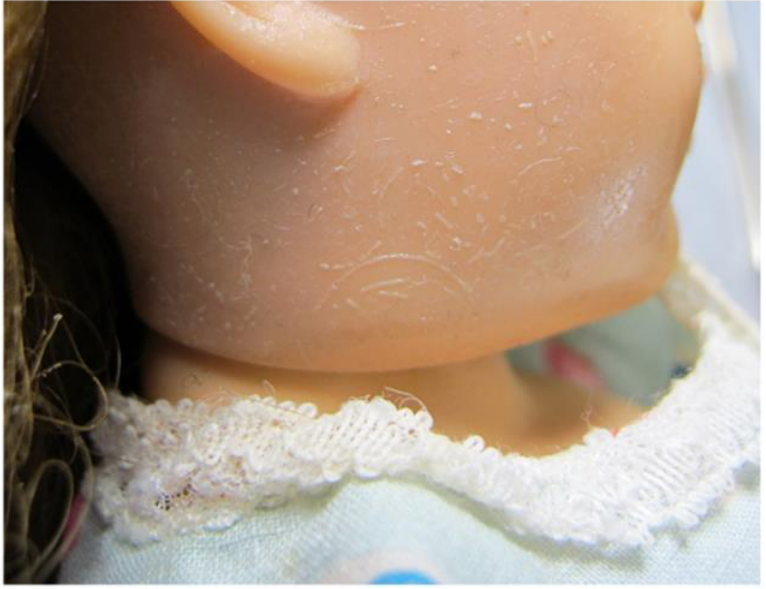
Figure 8. White surface crystals, observed on the PVC head of doll A8, which had a CA body. Image © Tate.